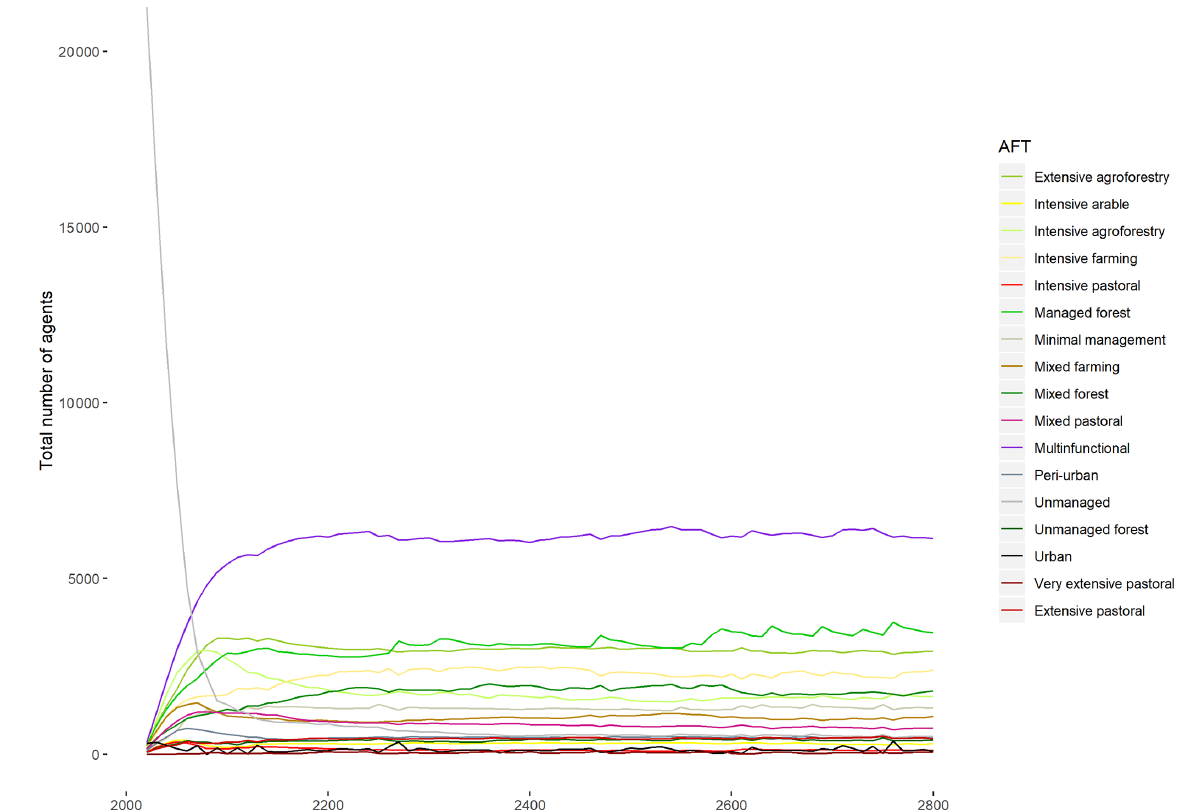
Figure B1. Numbers of agents belonging to each agent functional type throughout an 800-time-step simulation to check for stationarity.